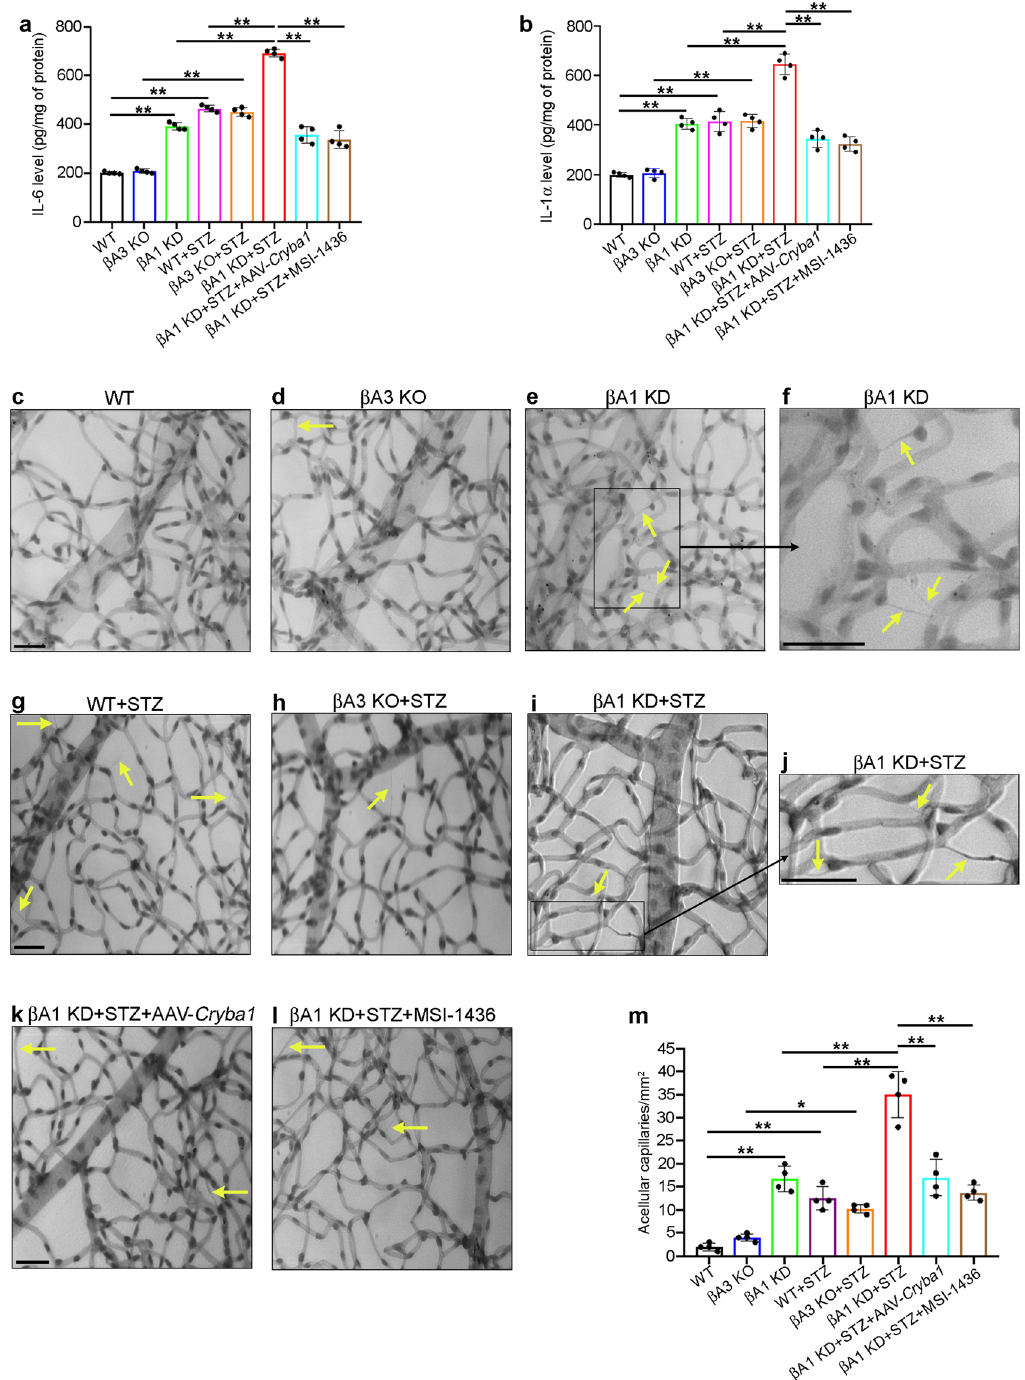
Fig. 7 PTP1B and Cryba1 are probable therapeutic targets for DR. ELISA analysis from total mouse retinal lysates showed increased a IL-6 and b IL-1 α in diabetic (STZ-treated) WT, β A3 KO, and especially in β A1 KD mice relative to non-diabetic littermates. In diabetic β A1 KD mice, intraperitoneal treatment (thrice weekly) with PTP1B inhibitor (MSI-1436), at a dose of 0.125 mg/kg body weight started 3 weeks after diabetes onset and continued for 5 weeks or a single intravitreal injection of AAV2- Cryba1 construct (1.64 × 10 12 vg/ml), rescued the IL-6 and IL-1 α levels. n = 4. ** P < 0.01. c – l Representative images of the retinal capillary network and quantitative graph to show the number of acellular capillaries ( m ), in diabetic and non-diabetic WT, β A3 KO and β A1 KD mice, showing increase in acellular capillaries (arrows) in non-diabetic ( e , inset zoomed in f ) or diabetic β A1 KD mice ( i , inset zoomed in j ), compared to WT mice ( c , g , and m ). β A3 KO mice ( d , h ) did not show any noticeable change in retinal vasculature relative to WT mice. MSI-1436 or AAV2- Cryba1 treatment reduced degenerative changes in the retinal vasculature (arrows in k and l , graph m ) in β A1 KD animals. n = 4. * P < 0.05, ** P < 0.01. Scale bar, 50 μ m ( c – e , g – i , k – l ). Scale bar, 100 μ m (insets, f and j ).